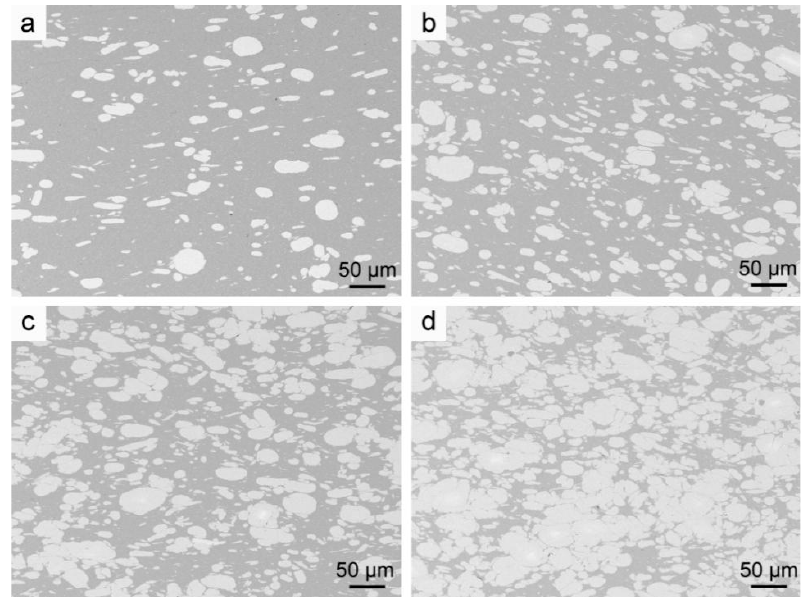
Figure 4. SEM images of the fabricated CrCoNi/Al composites. ( a ) 5 wt.% CrCoNi/Al; ( b ) 10 wt.% CrCoNi/Al; ( c ) 15 wt.% CrCoNi/Al; ( d ) 20 wt.%